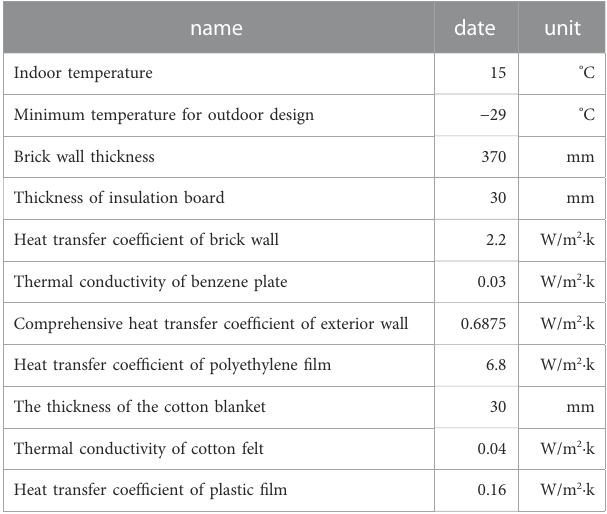
TABLE 1 Thermal parameters of greenhouse design.